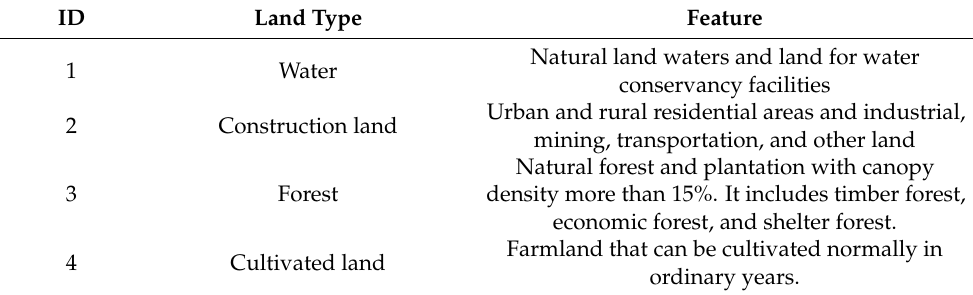
Table 1. Land-use classification